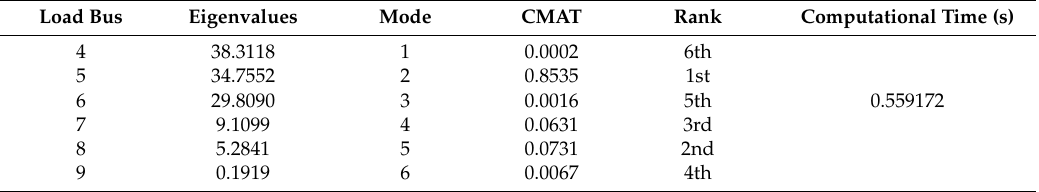
Figure 3. Voltage magnitudes of the western system coordinating council (WSCC) 9-bus power system. Table 3. Results of the conventional modal analysis technique (CMAT) of the WSCC 9-bus test system. Load Bus